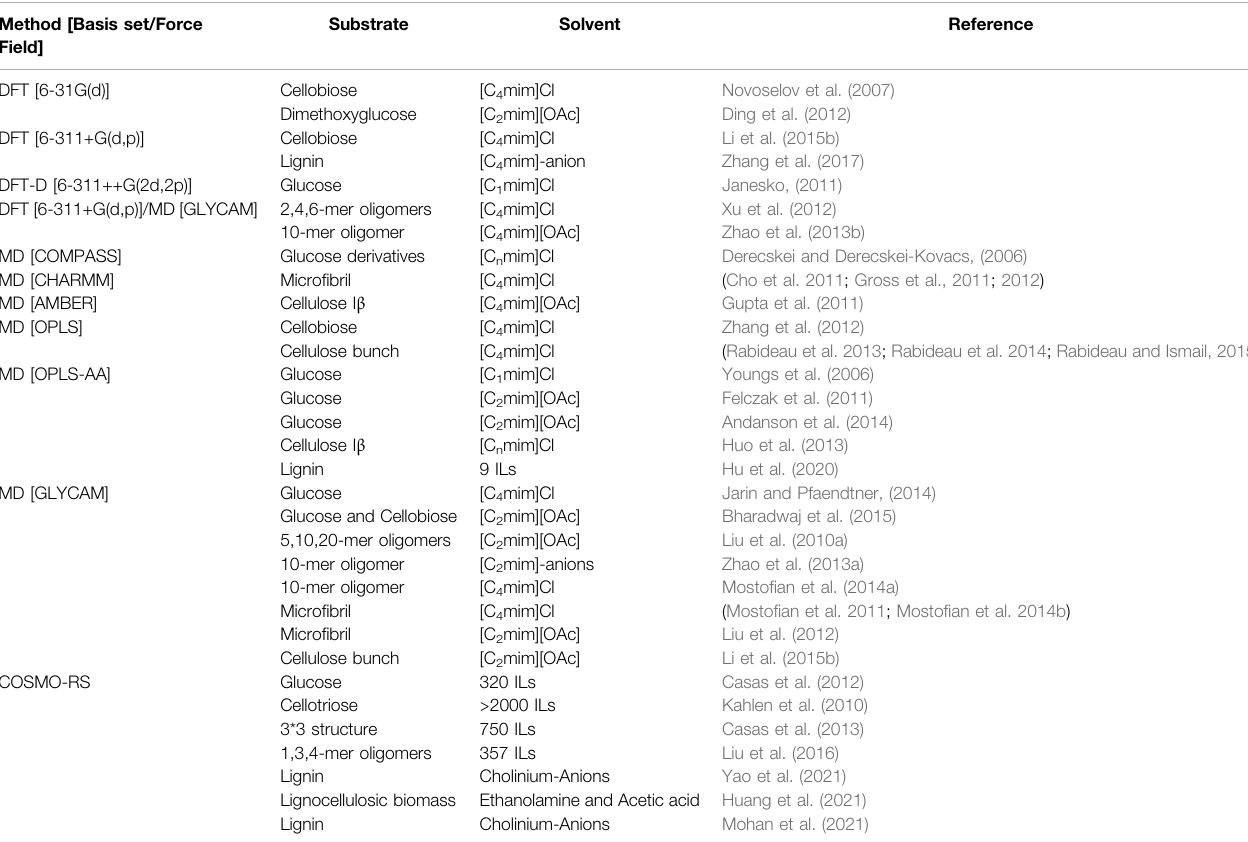
TABLE 1 | Molecular simulation techniques used for understanding interactions between biomass-solvent. Method [Basis set/Force